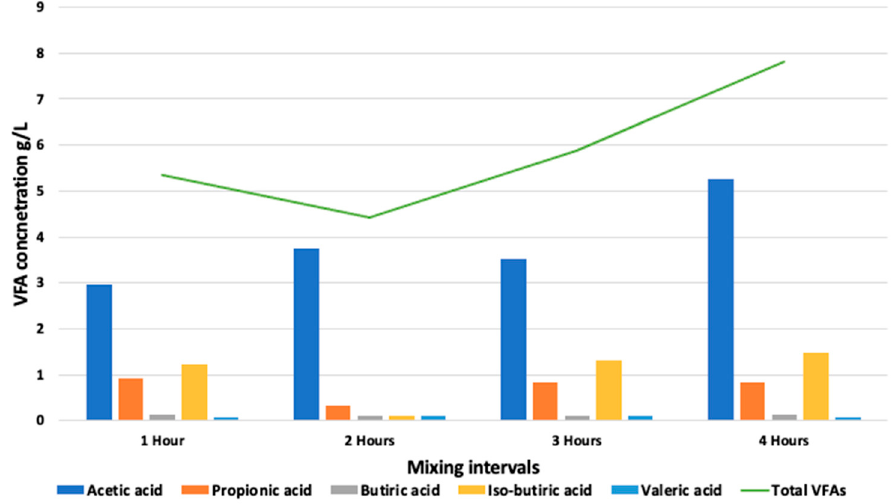
Figure 5. pH levels during the various mixing intervals throughout the experiment.